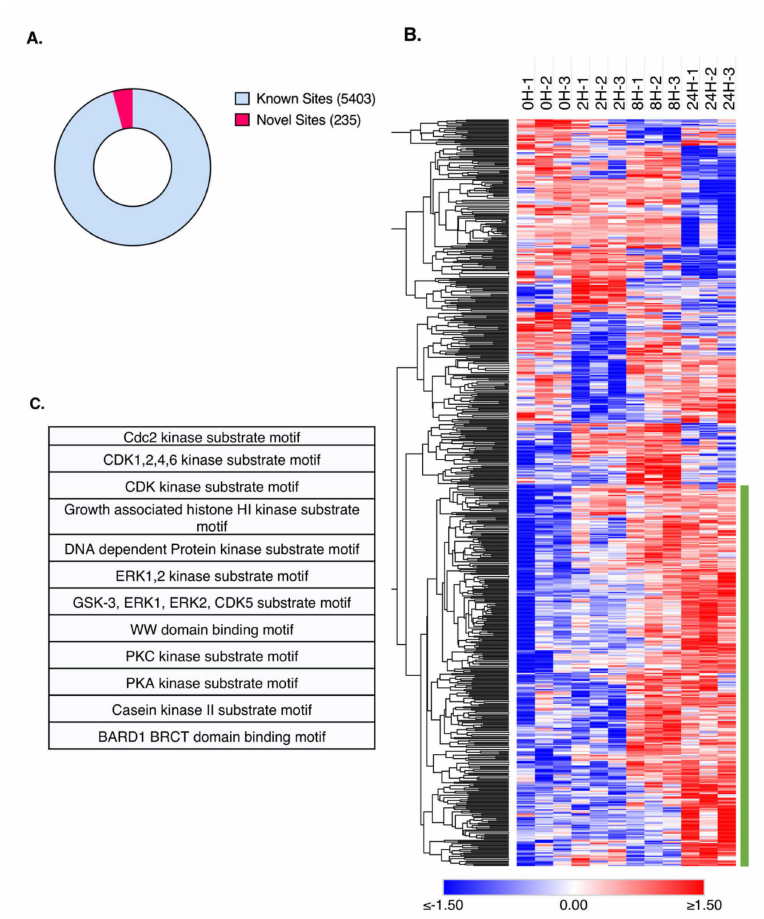
Figure 4. Phosphoproteomic analysis of TNF α -treated hepatocytes. ( A ) Number of novel phospho- sites (red) identified in this study relative to the total number of phosphosites identified. Phosphosites were categorized as “novel sites” based on the PhosphoSitePlus database. ( B ) Heatmap representa- tion of Z-scored Log2(LFQ) values of significantly regulated phosphosites. Significant phosphosites ( p < 0.05 by ANOVA) were clustered based on “one minus Pearson correlation”, and the cluster of interest is highlighted by a green bar located on the left of the cluster. Red hue represents upregulated sites, while blue hue represents downregulated sites. ( C ) Substrate motif enrichment analysis of phosphosites identified in the highlighted cluster, shown in Figure